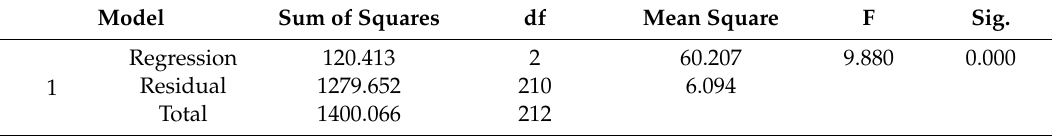
Table 3. ANOVA test between religious belief (DV) and both social and personal belief (IV).